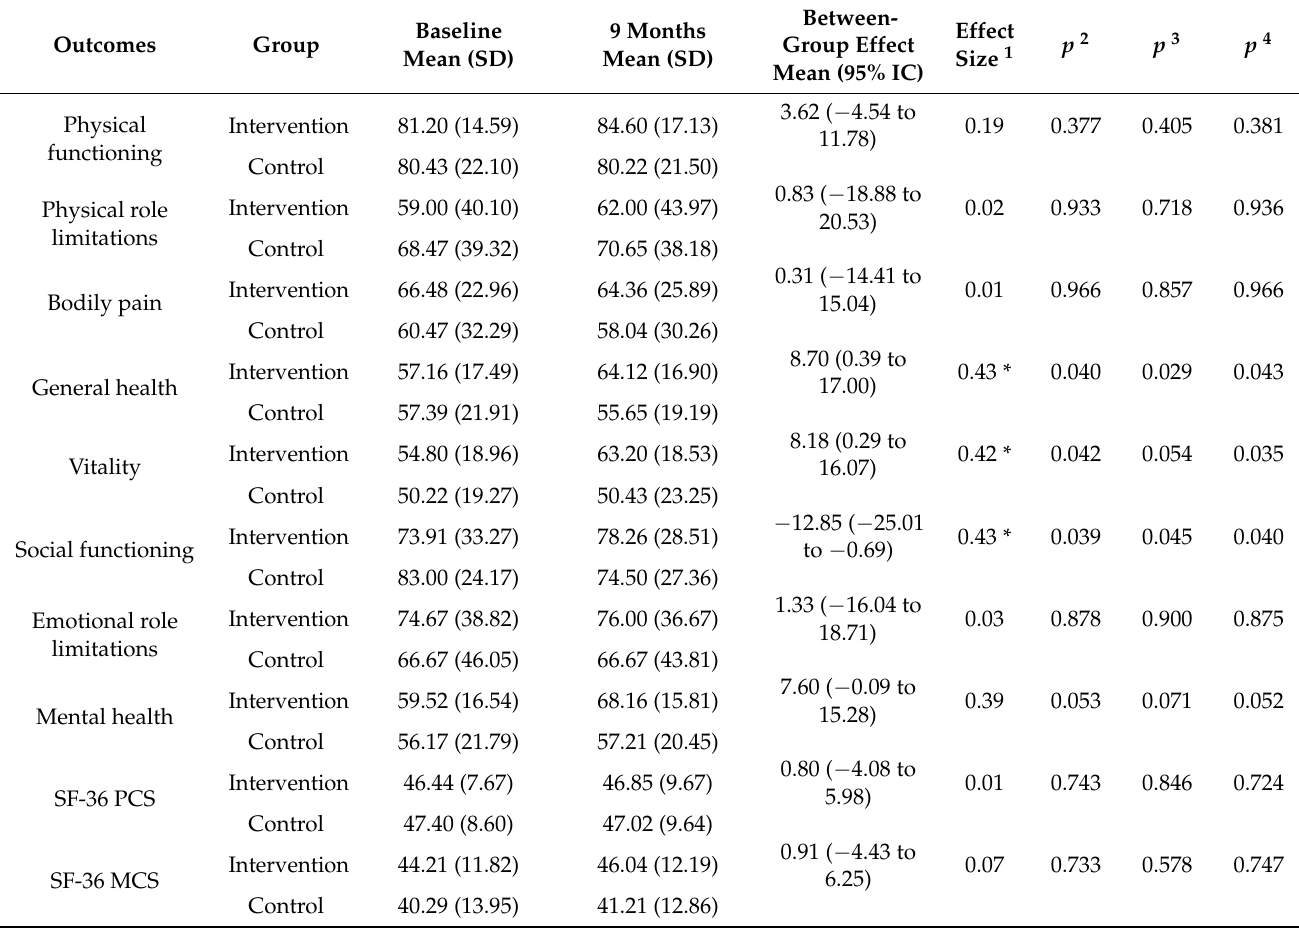
Table 2. HRQoL at baseline and after 9-month intervention.